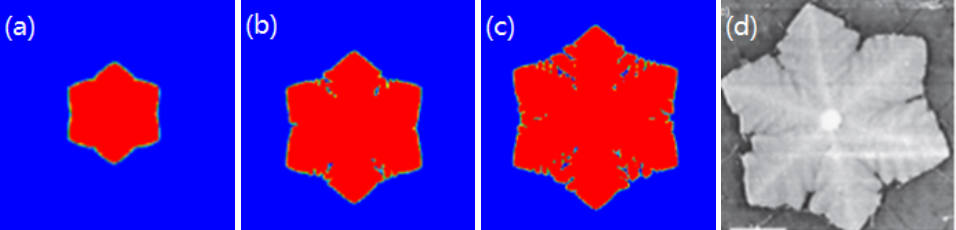
Figure 2. When K 0 = 1.1, and the morphology of dendrites is obtained by numerical simulation. (( a – c ) are the numerical simulation results with time iteration steps of 1000, 2000 and 3000, respectively. ( d ) is the experimental